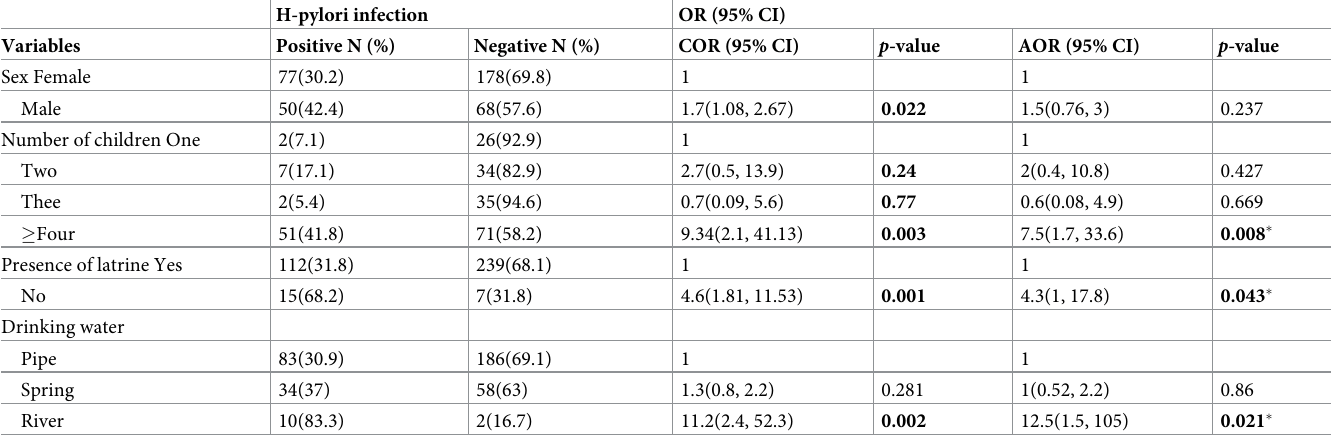
Table 3. Factors independently associated with H-pylori infection among dyspepsia patients at DTCSH, Northwest Ethiopia, 2020 (N =